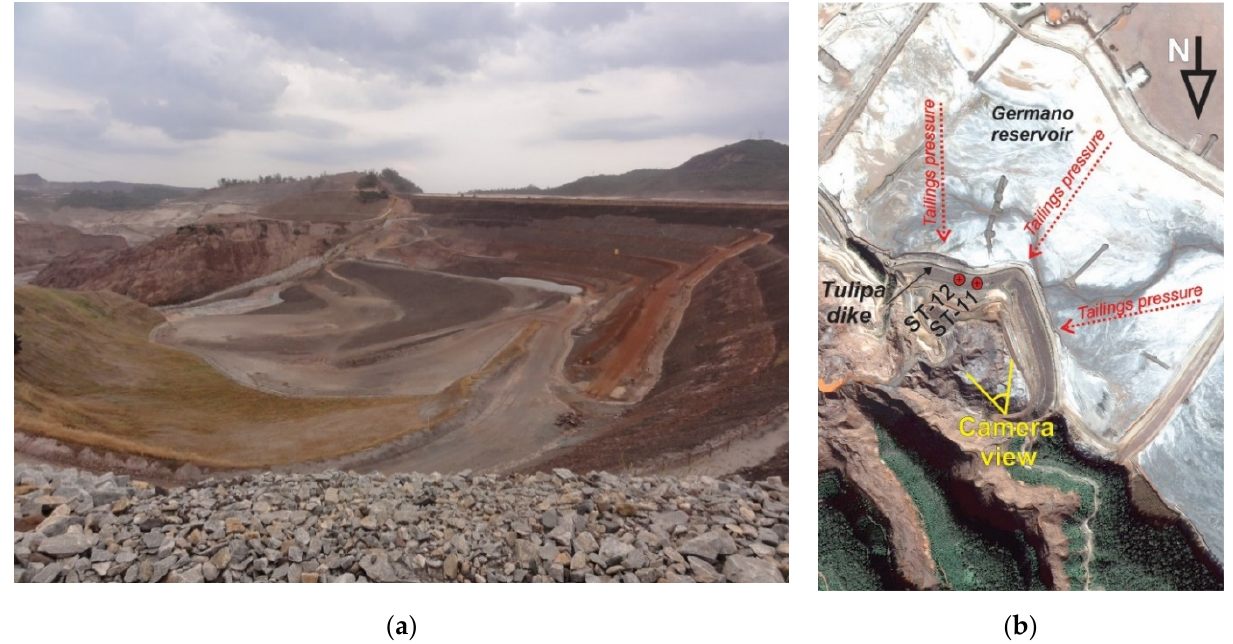
Figure 10. ( a ) View from the East edge of the Tulipa dike, with the Germano Reservoir on the opposite